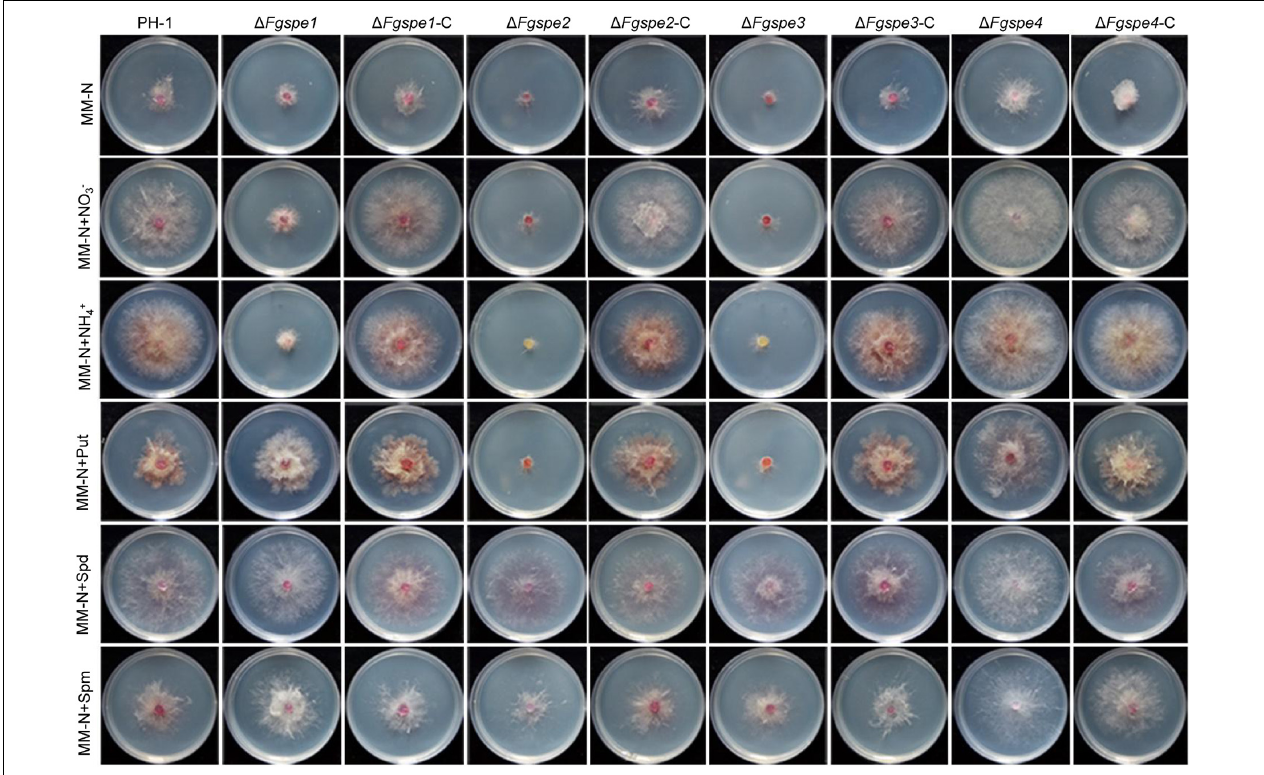
FIGURE 3 | Polyamines restores the growth defection of (cid:49) Fgspe mutants. Colony morphology of PH-1, deletion mutants, and complementation mutants in MM-N medium supplemented with different nitrogen sources at 5 mM. Photos were recorded at 25 ◦ C after 3